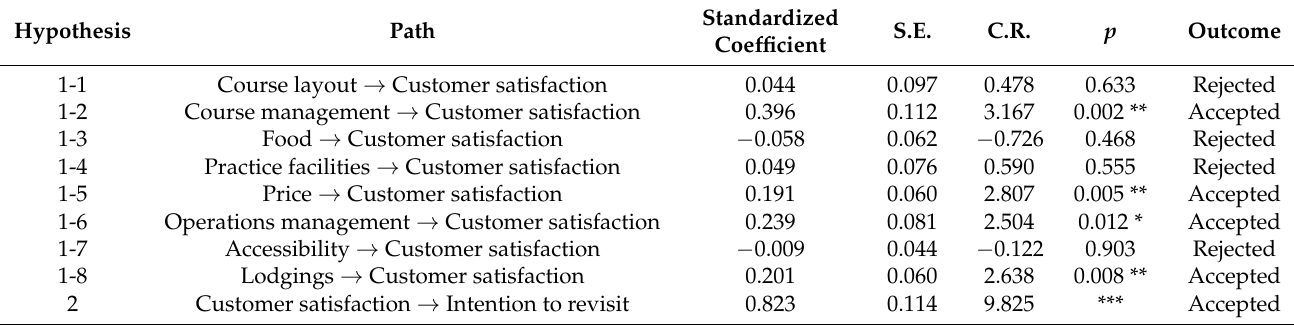
Table 9. The results of testing H1 and H2.